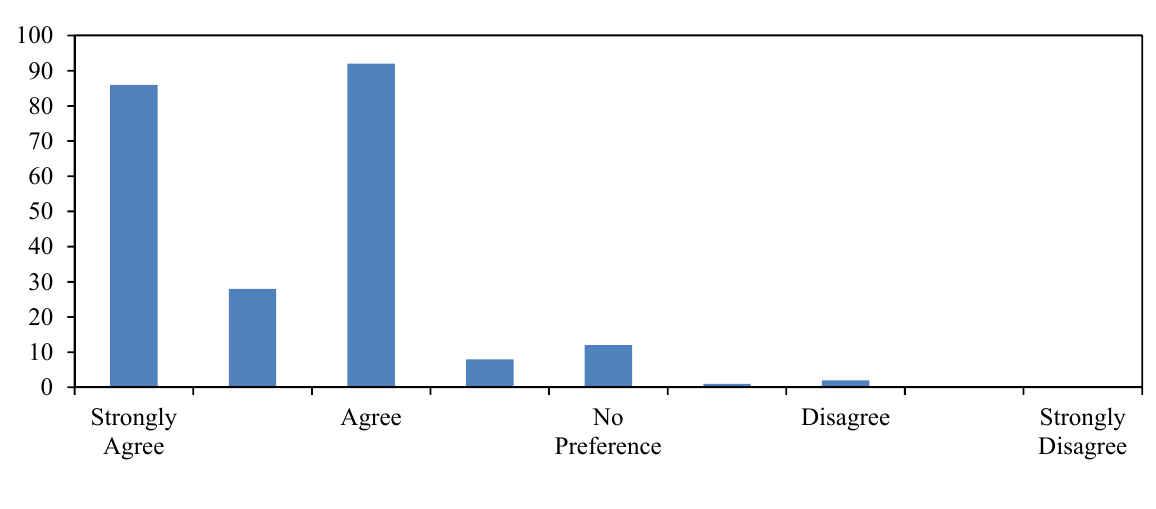
Figure 6. Graph of responses to the statement “I use/would use a computer to identify trends in